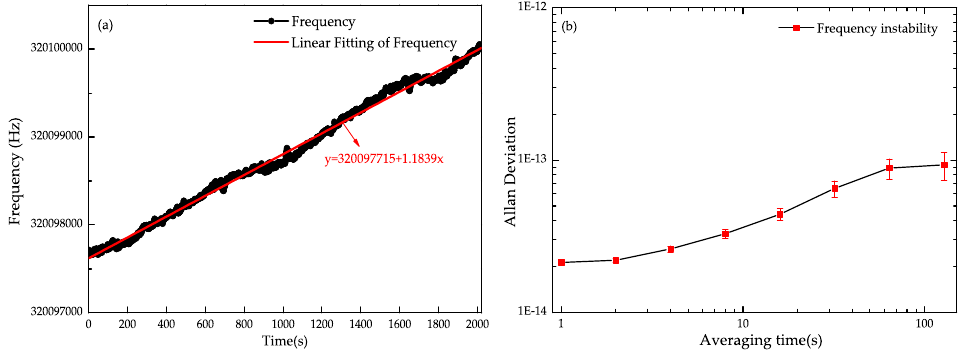
Figure 9. ( a ) Beat signal drift with time; ( b ) frequency stability